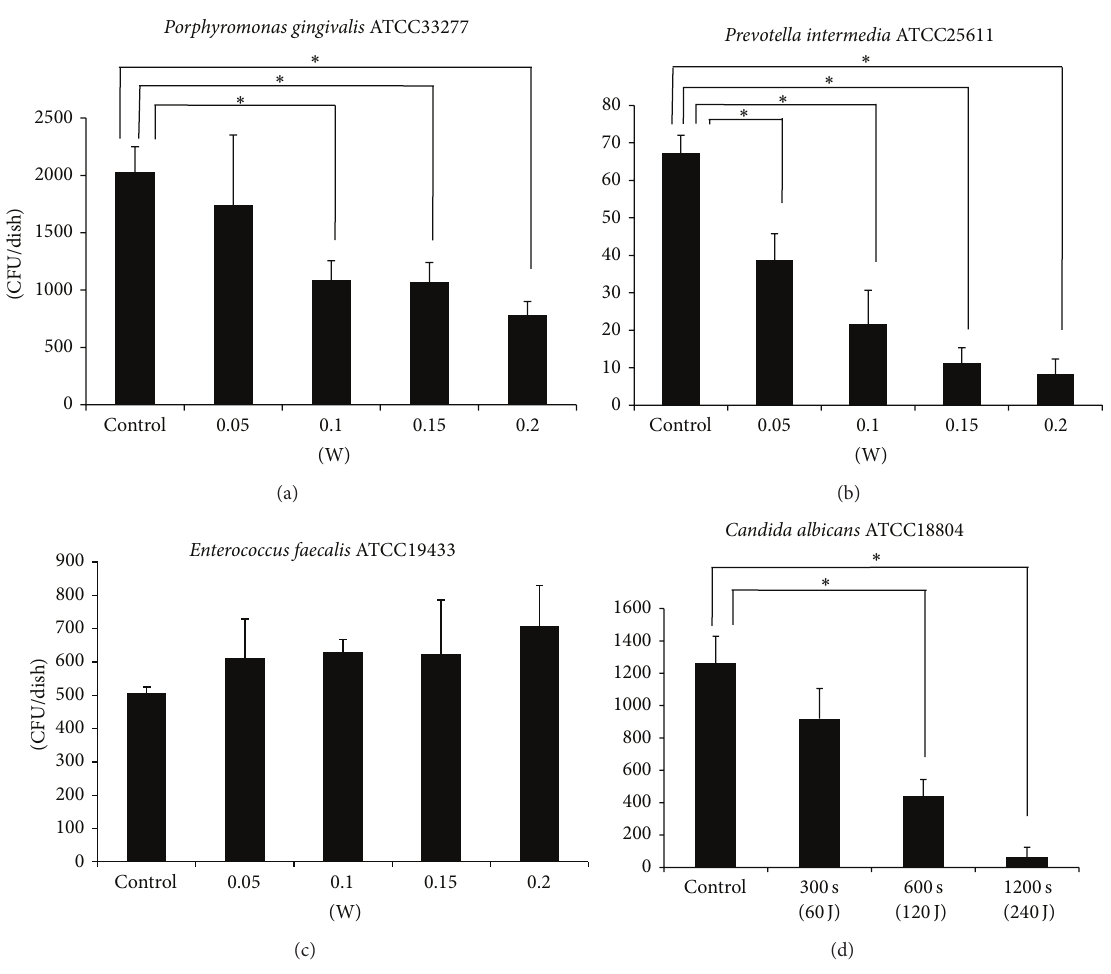
Figure 4: (a) Effect of 300 sec laser irradiation on P . gingivalis growth. (b) Effect of 300 sec laser irradiation on P . intermedia growth. (c) Effect of 300 sec laser irradiation on E. faecalis growth. (d) Effect of laser irradiation at 0.2 W output on C. albicans growth. ∗ 𝑃 < 0.05